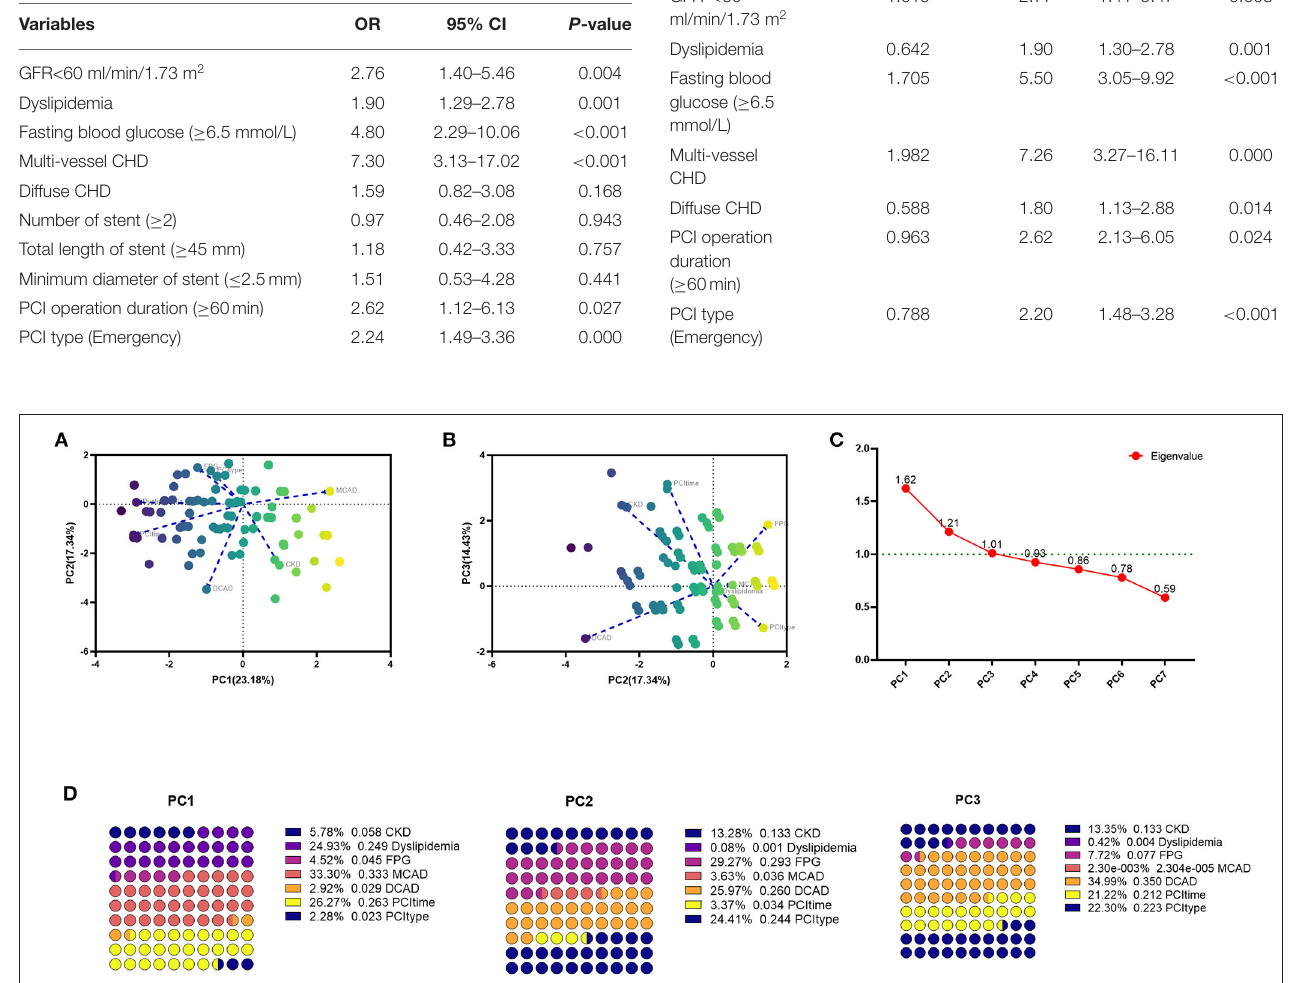
FIGURE 1 | CATPCA analysis of clinical variables in the PSM cohort. (A,B) CATPCA biplot—component loadings of the most explanatory variables. (C) The scree plot of CATPCA. (D) Risk factors in PC1, PC2, and PC3.